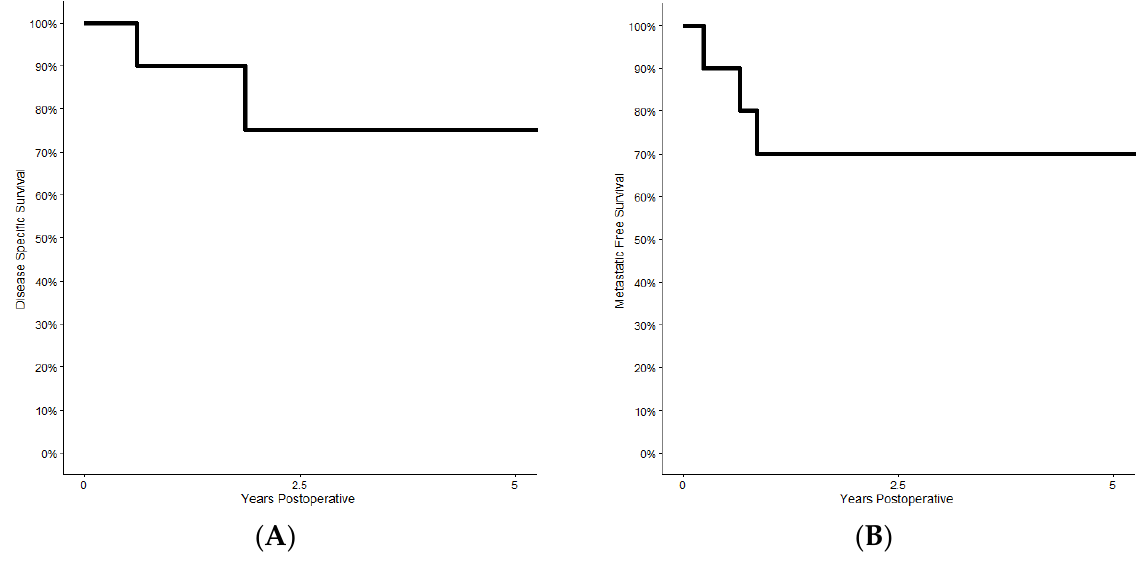
Figure 3. Following resection and reconstruction of the upper extremity with a pedicled latissimus flap, the 5 year disease-specific ( A ) and metastatic-free survival ( B ) were 75% and 70%, respectively.